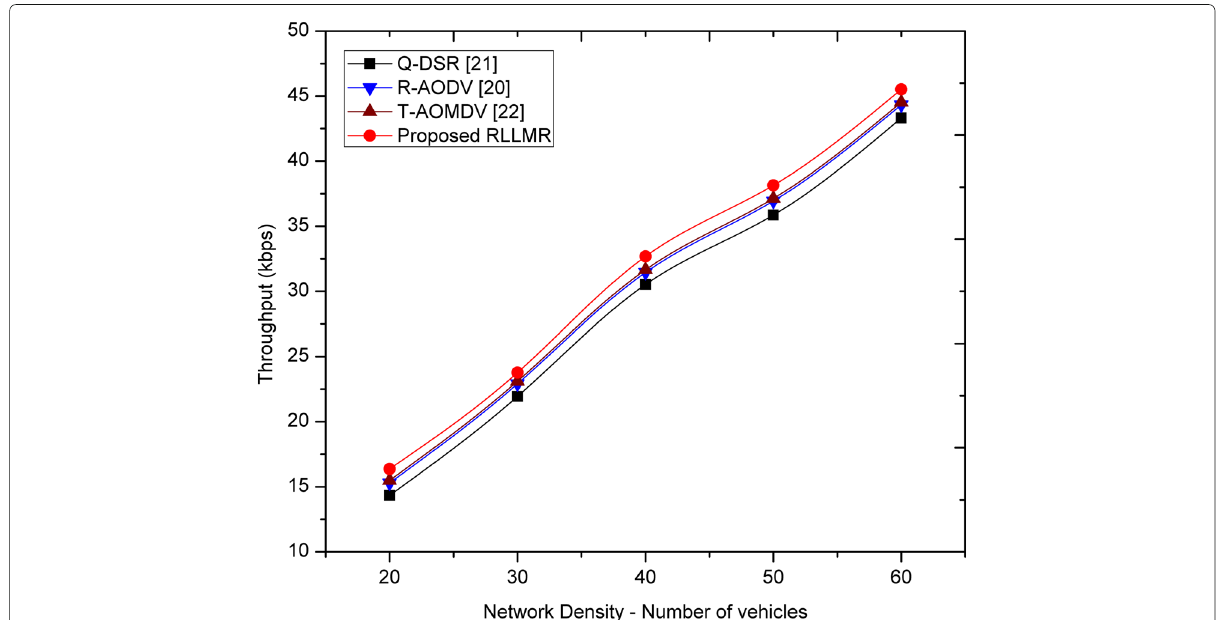
Fig. 9 Effect of different vehicles over average throughput (Average speed 60 Km/h, R 1000m, t 10s)